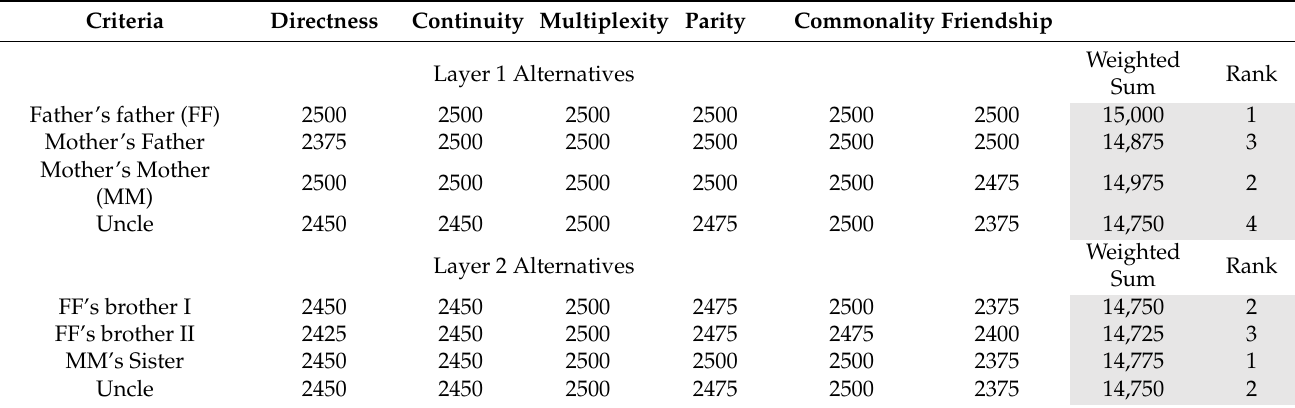
Table 2. Weighted